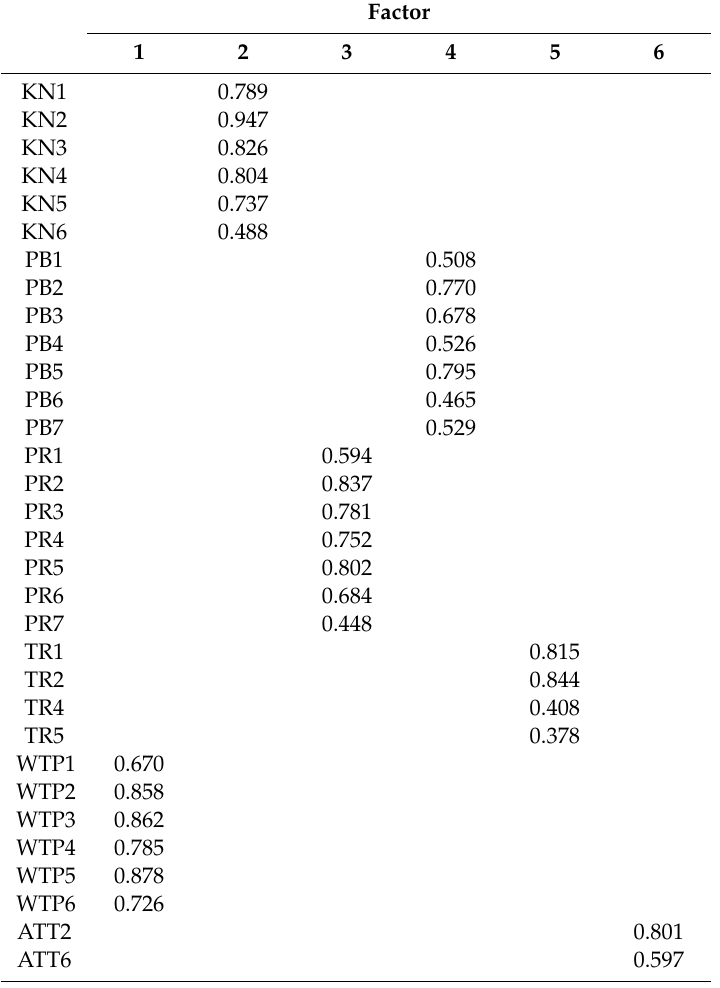
Table A2. Exploratory Factor Analysis EFA (Second